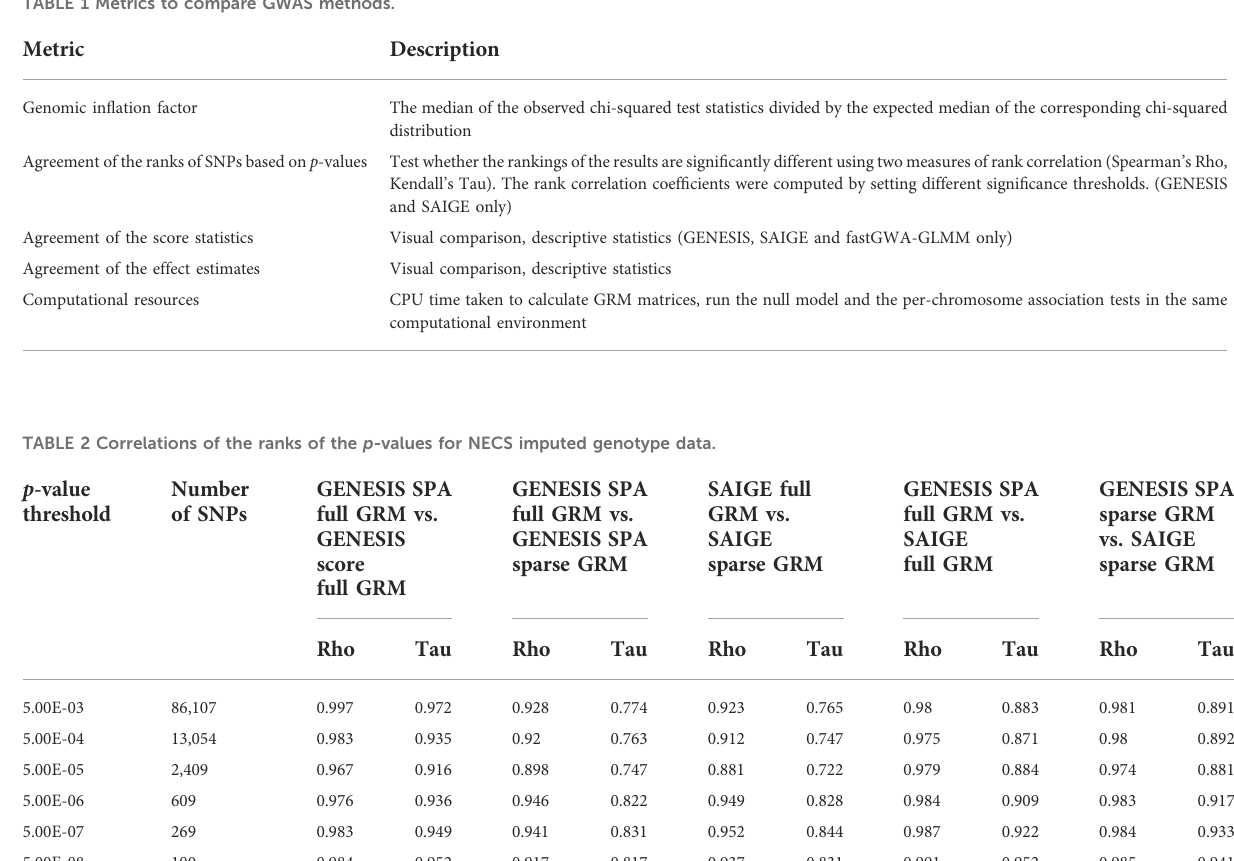
TABLE 1 Metrics to compare GWAS methods.